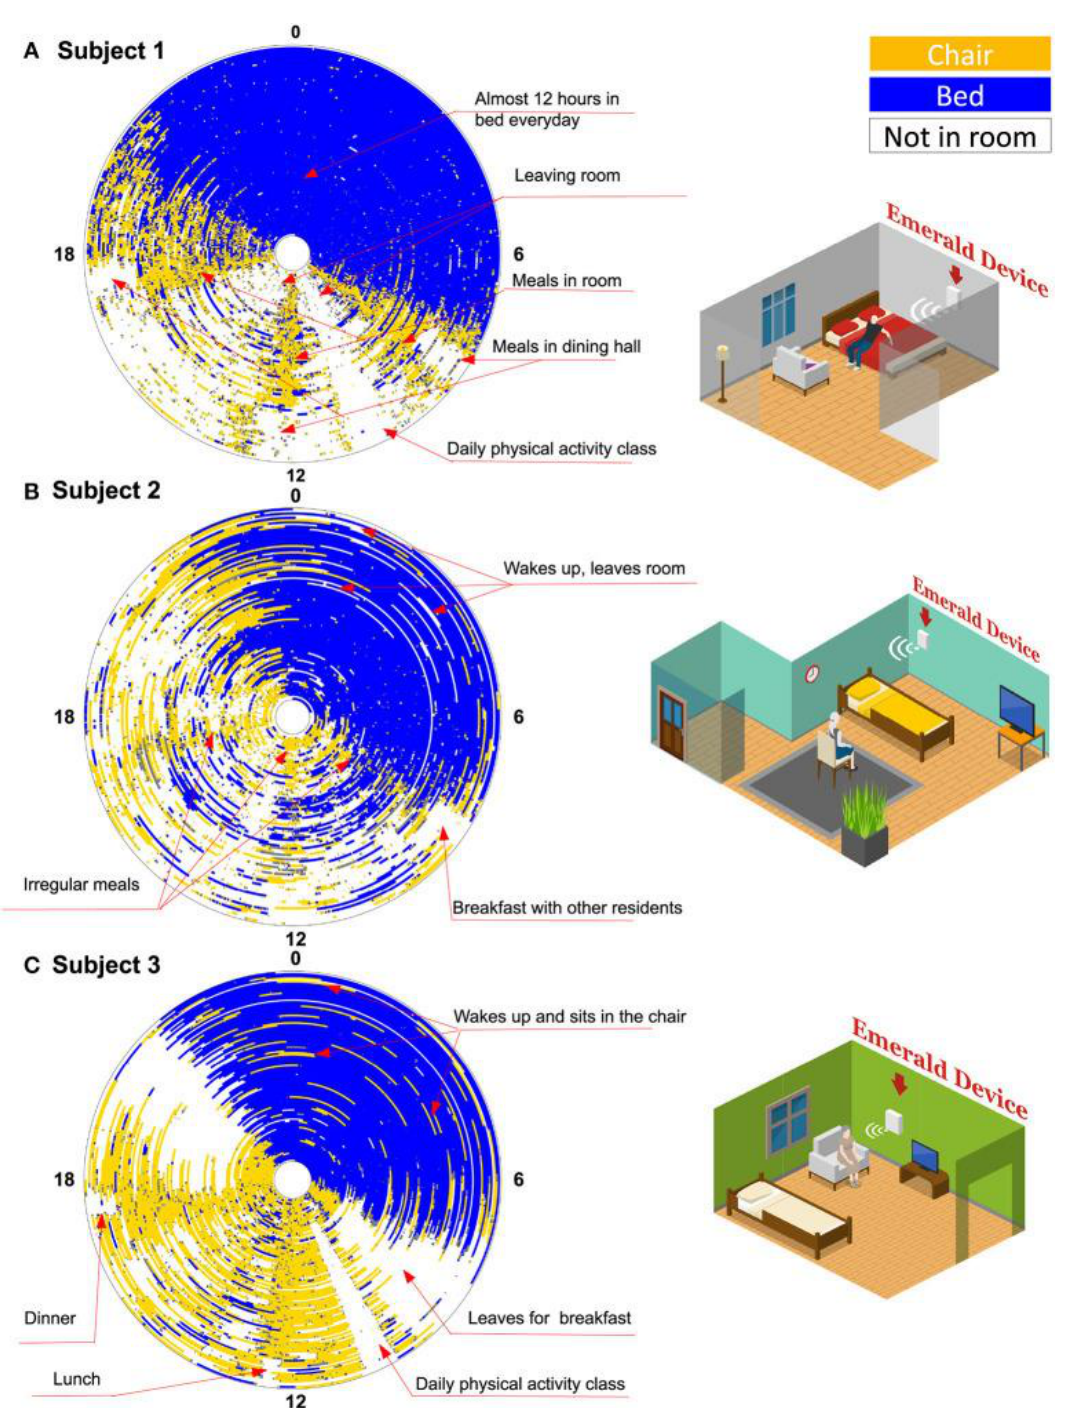
Figure 5. The Emerald RF sensor. A longitudinal view of behavior patterns of three subjects basic activities after becoming COVID negative with different colors referring to different locations inside and outside the room (reproduced under the terms and conditions of the Creative Commons At- tribution (CC BY) license from [61]). Attribution (CC BY) license from